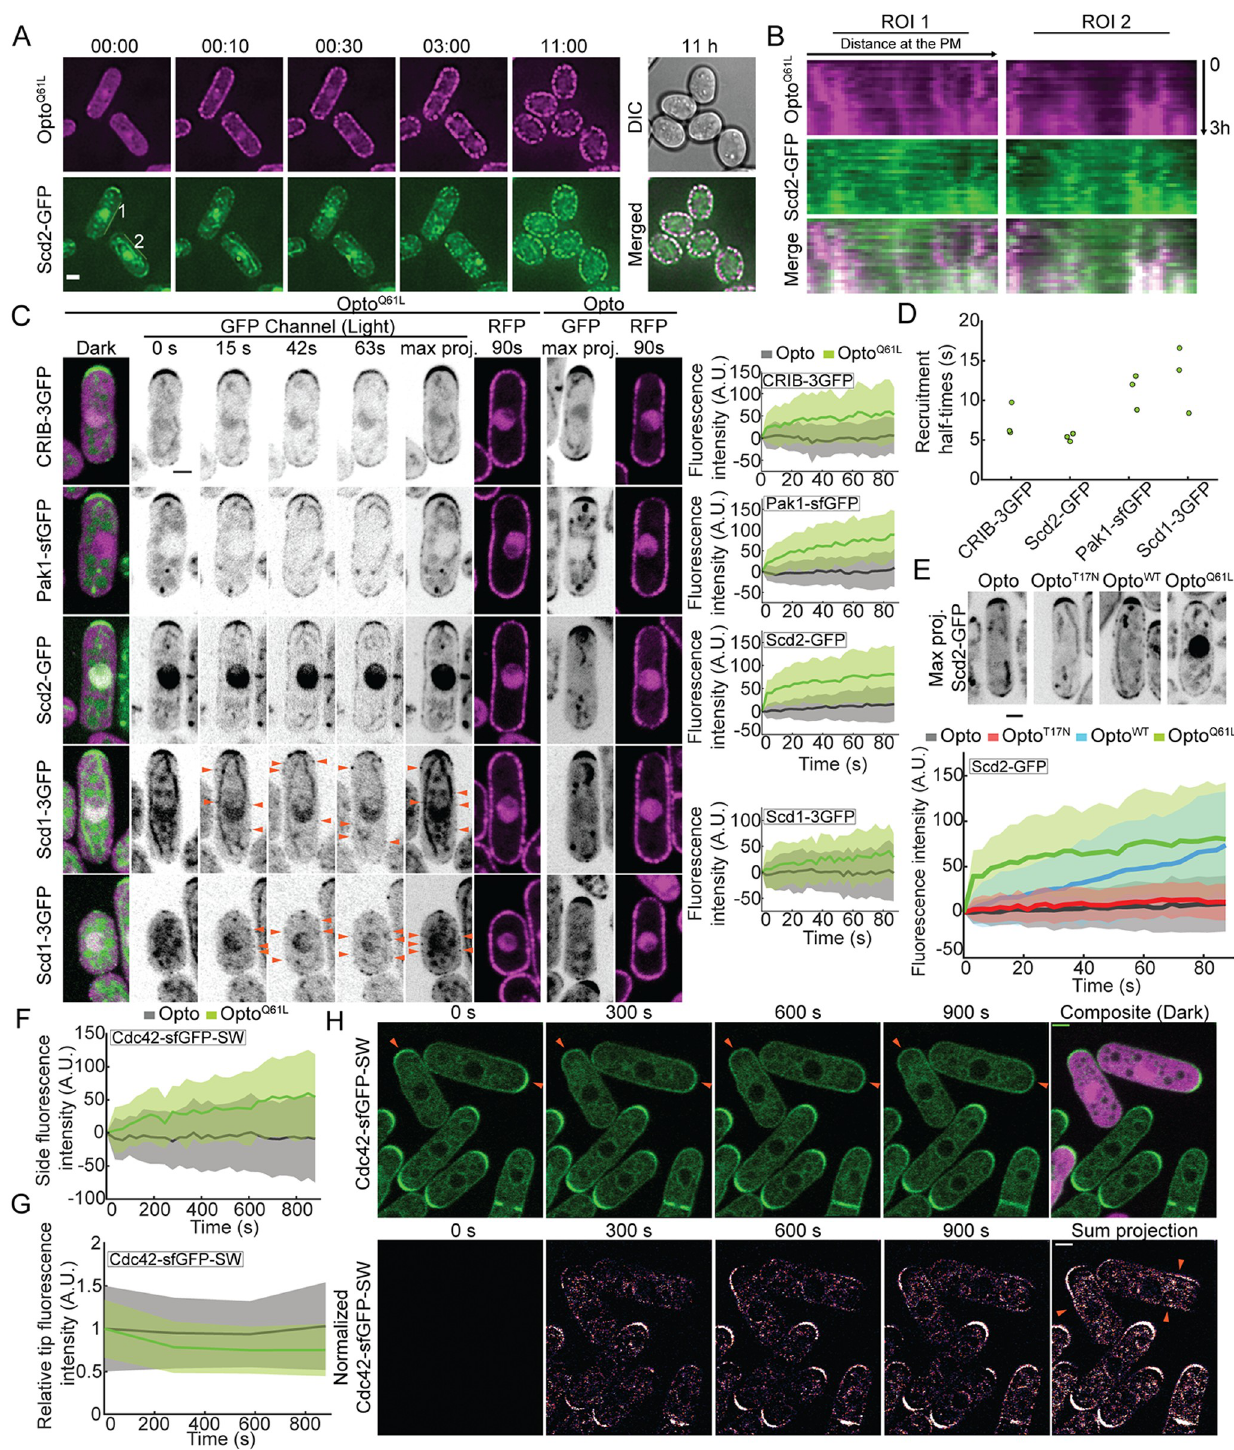
Fig 3. Visualizing the positive feedback triggered by Cdc42-GTP. (A) Blue light–dependent Scd2-GFP relocalization to Opto Q61L foci during the transition from polar to isotropic growth (GFP, RFP, and DIC channels were acquired every 10 min). ROIs (2 pixel width) highlight cortical regions from where kymographs shown in (B) were generated. Time is shown in hh:mm. (B) Kymographs generated from ROIs shown in (A) over the first 3 h of time- lapse acquisition. x-axes of kymographs represent distance at the cell side and y-axes represent time. (C) Opto Q61L -induced cell-side relocalization of CRIB- 3GFP probe and endogenously tagged Pak1-sfGFP, Scd2-GFP, and Scd1-3GFP in otherwise wt cells (B/W inverted images). Merged color images on the left show the dark, inactive state of Opto Q61L cells. The GFP max projection (“max proj.”) images show GFP maximum-intensity projections of 30 time points over 90 s and illustrate best the side recruitment of GFP-tagged probes. Orange arrowheads point to lateral Scd1-3GFP signal. RFP images show the cortical recruitment of CRY2PHR-mCherry-Cdc42 Q61L (Opto Q61L ) and CRY2PHR-mCherry (Opto) at the end of the time lapse. Quantification of GFP signal intensity at cell sides is shown on the right. N = 3; n > 20 cells per experiment; p CRIB-3GFP = 2.9e -13 ; p Pak1-sfGFP = 4.8e -22 ; p Scd2-GFP = 3.1e -18 ; p Scd1-3GFP